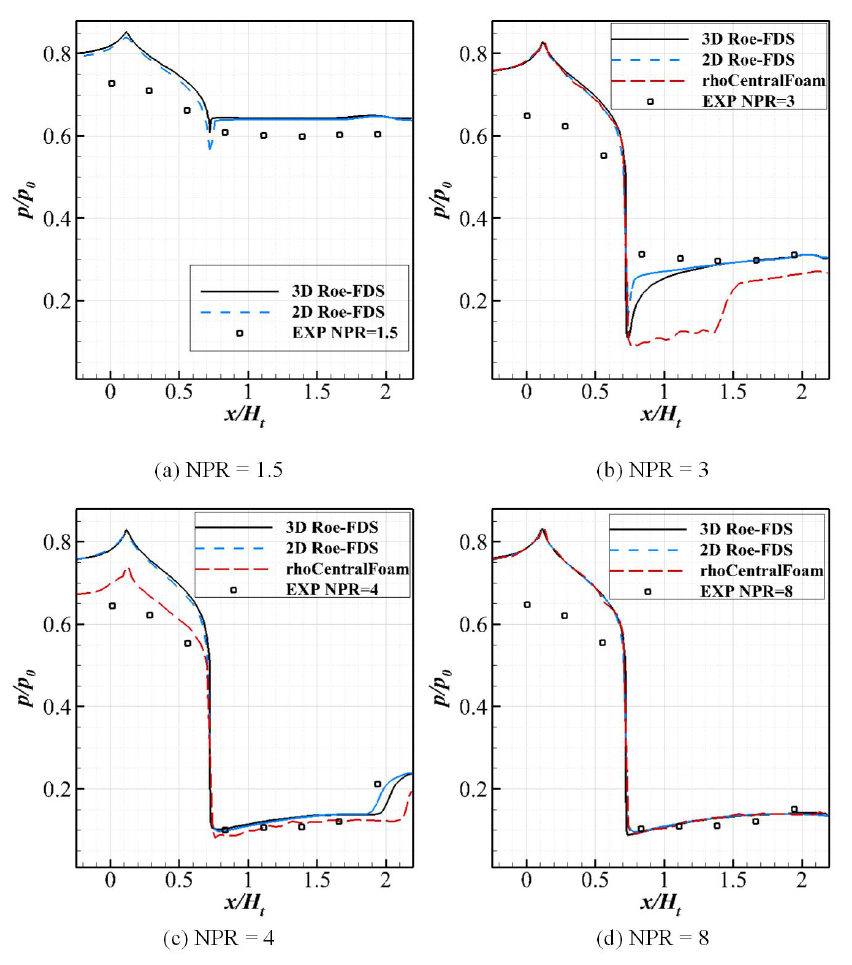
Figure 5. Comparison of the pressure on the ramp between the numerical simulation and experimen- tal measurements [28]. ( a ) NPR = 1.5, high subsonic separated pipe flow; ( b ) NPR = 3, flow attached to the starting point of the ramp wall; ( c ) NPR = 4, the jet is almost fully attached to the ramp wall; ( d ) NPR = 8, fully expanded